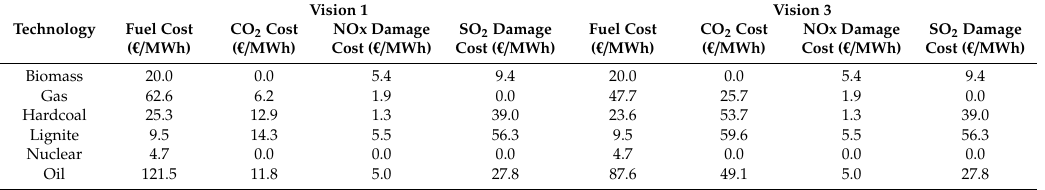
Table 2. Components of variable electricity production costs per technology and scenario in 2030.